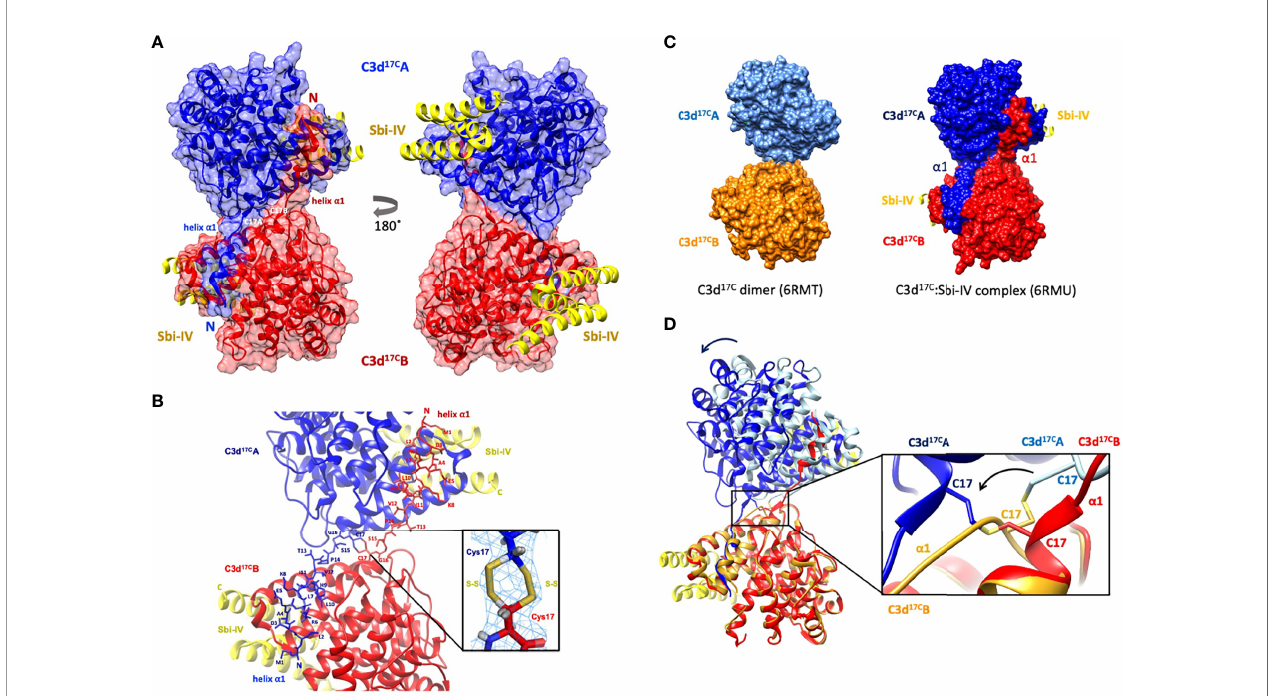
FIGURE 1 | Crystal structure of a human C3d 17C dimer in complex with Sbi-IV at 2.4 Å resolution. (A) Ribbon diagram of the C3d 17C :Sbi-IV dimer complex showing the cysteine C17 disul fi de linked monomers in red and blue, respectively. A reciprocal 3D domain swap of both N-terminal a 1 helices can be observed between the two C3d chains in the dimer, involving amino acids M1-G16. (B) Enlarged view of the C3d 17C dimer interface showing the side chains of helix a 1 residues M1-C17. Inset: 2Fo-Fc electron density contoured at 1.0 s of two possible interchain disul fi de bonds (conformer A: 2.04 Å, conformer B: 2.06 Å) with a preference for the conformer B disul fi de (occupancy: 0.66). The structure of C3d 17C :Sbi-IV dimer complex was submitted to the Protein Data Bank with PDB accession code: 6RMU. See Supplementary Tables S1, S2 for data collection and re fi nement statistics. (C) Comparison of the unliganded C3d 17C dimer (PDB accession code 6RMT, with the molecular surface representations of the C3d monomers highlighted in gold and light blue) and the C3d 17C :Sbi-IV dimer complex (6RMU, with the C3d monomers shown in red and dark blue, and Sbi-IV in yellow), clearly showing the 3D domain swap of the N-terminal a 1 helices in the latter dimer. (D) Superpositioning of the C3d A chains in both unliganded and Sbi-IV bound C3d dimer structures, highlighting the overall changes in relative orientation of the C3d B-chain within the unliganded C3d 17C and helix-swapped dimers upon superpositioning of A-chain (left), and the conformational differences in disul fi de bond arrangement between both dimers (right). The images produced in this fi gure were generated using Chimera